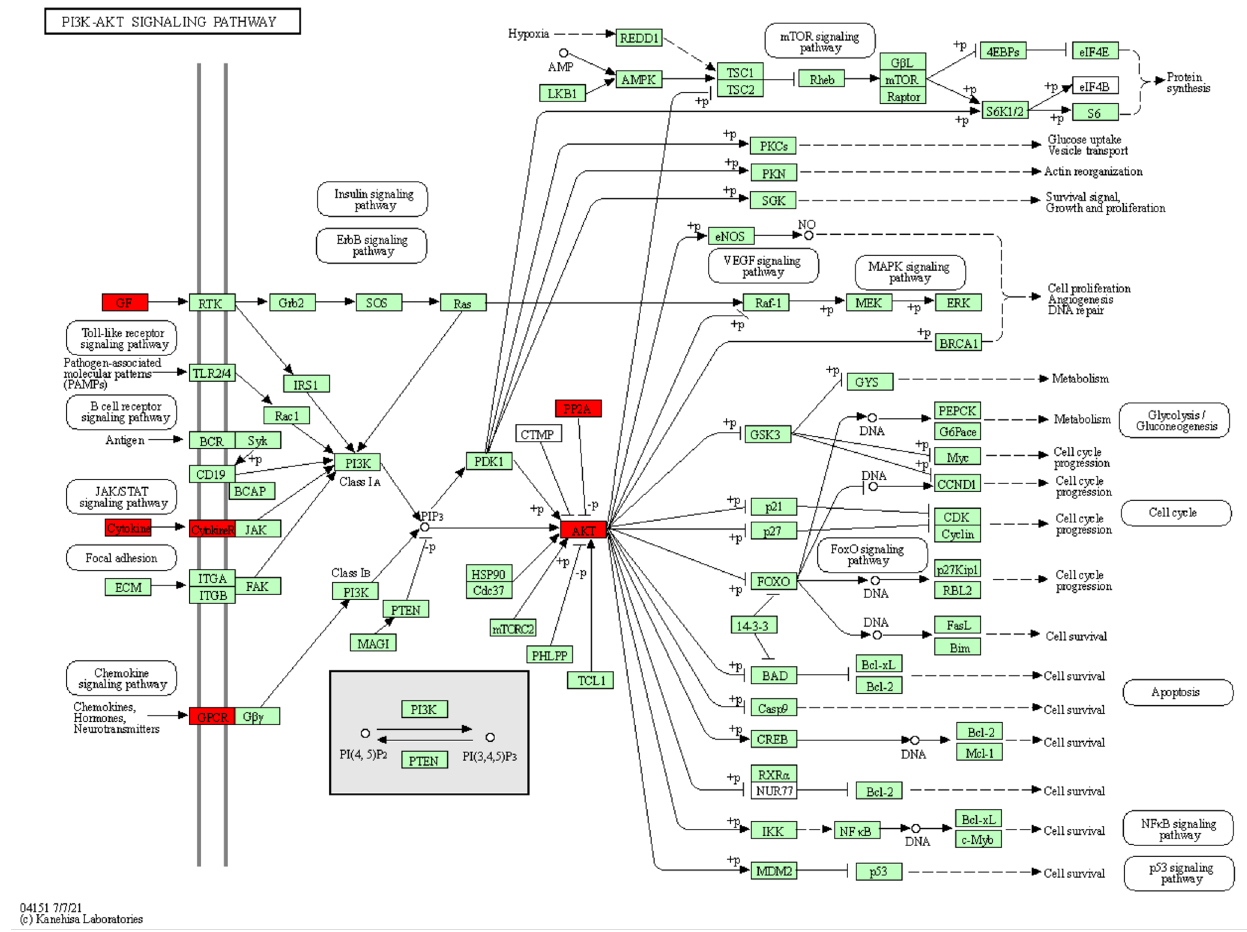
Figure 4. The location of the upregulated miRNA target genes in the PI3K-Akt signalling pathway. The target genes of the upregulated miRNA are